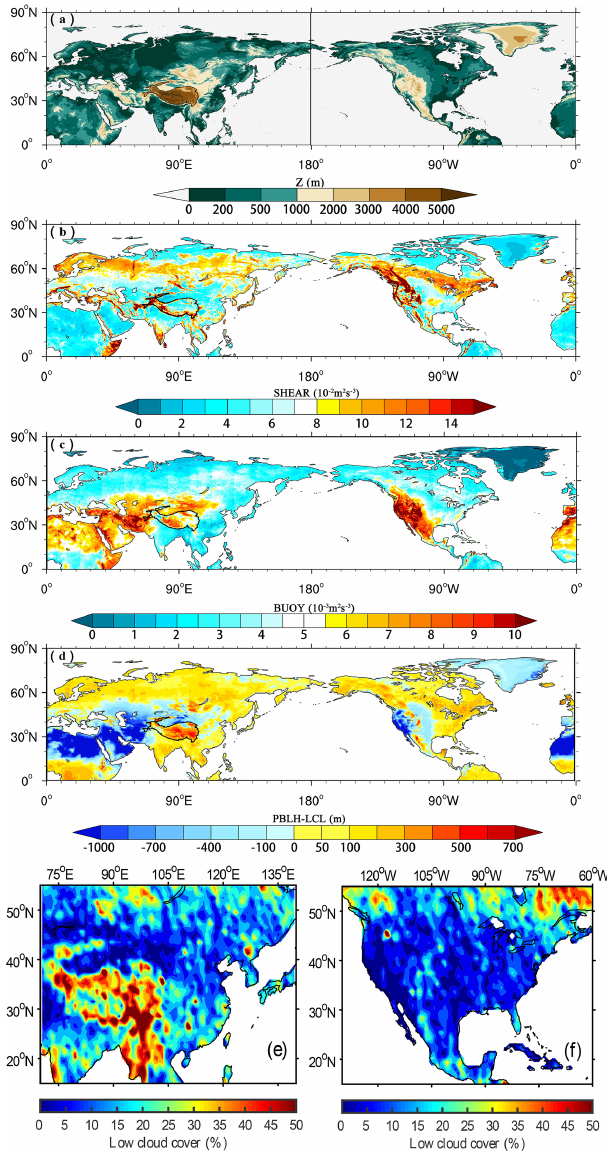
Figure 7. The spatial distribution of (a) ground-level elevation (m), (b) ST (10 − 2 m 2 s − 3 ), (c) BT (10 − 3 m 2 s − 3 ), and (d) PBLH–LCL (m) derived from ERA5 reanalysis data at 14:00LT in the Northern Hemisphere in summer. Panels (e) and (f) are the summer mean LCC (%) derived from CloudSat satellite data at 14:00LT in East Asia and North America,